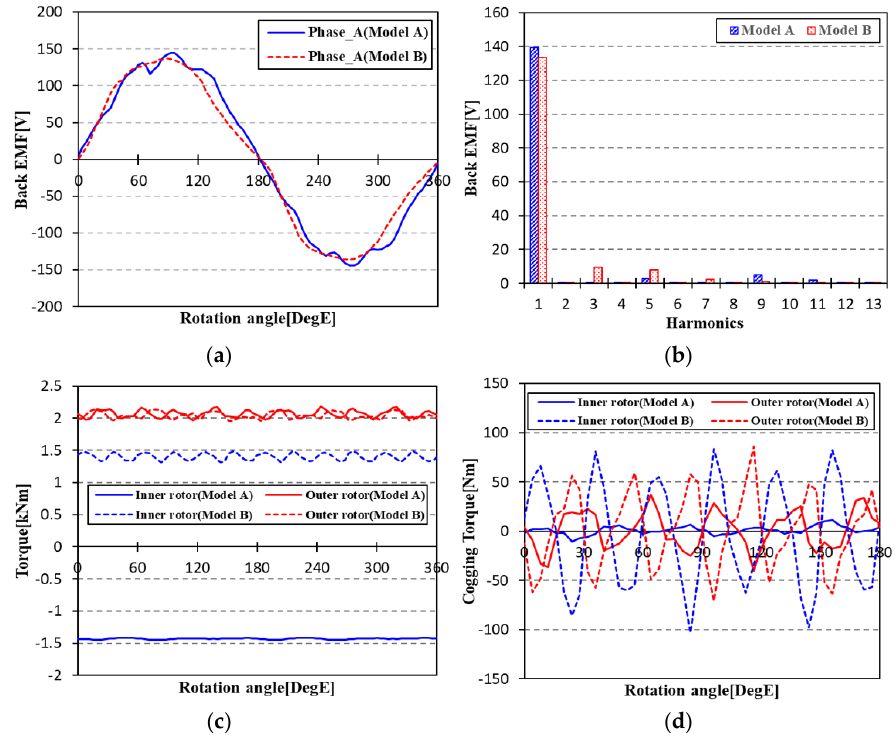
Figure 9. Electromagnetic characteristics of 45kW ‐ class MG ‐ PMSM design models with concentrated winding (@Rated speed): ( a ) Full ‐ load back ‐ EMF; ( b ) Full ‐ load back ‐ EMF harmonics; ( c ) Full ‐ load torque; ( d ) Cogging torque. Table 5. Comparisons of 45kW ‐ class MG ‐ PMSM Design Models with Concentrated winding.